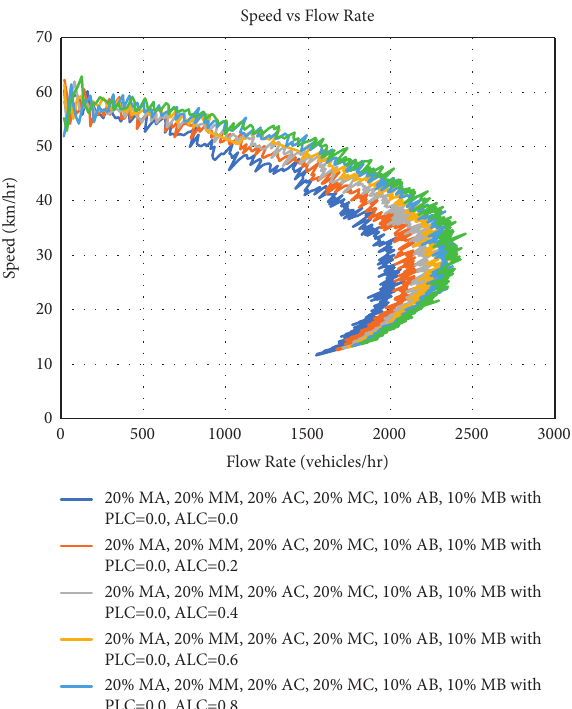
Figure 4: Speed vs. flow rate fundamental diagrams for different compositions of MA, MM, AC, MC, AB, and MB with different values of ALC when PLC is fixed at 0.